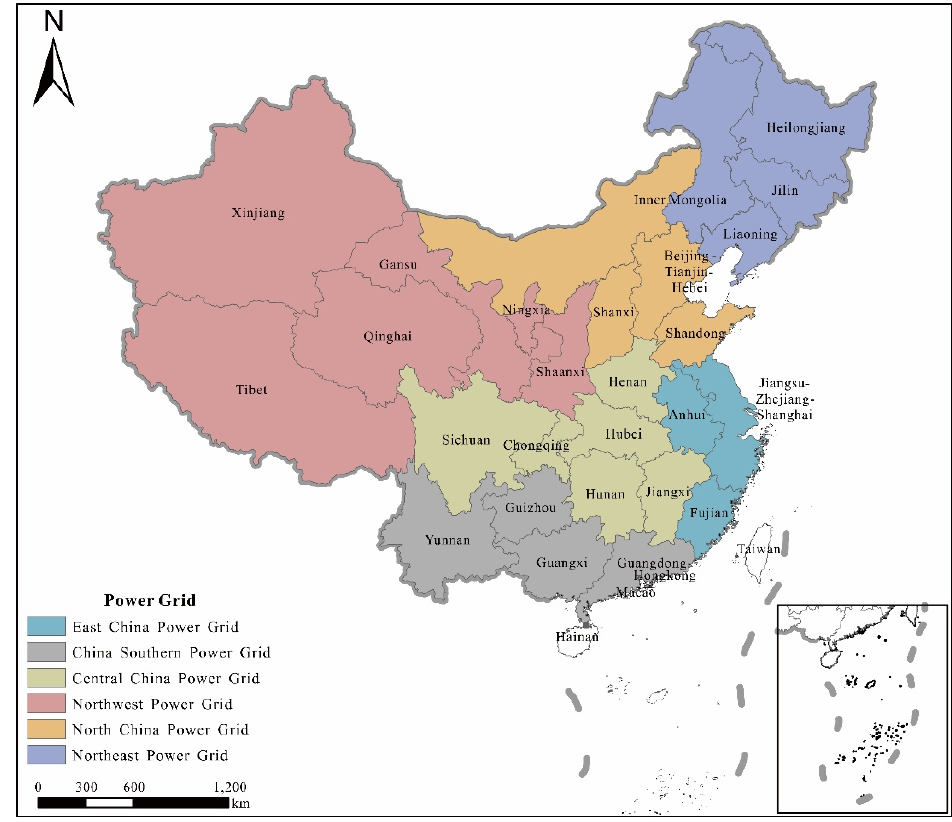
Figure 2. Chinese mainland regional power grid.